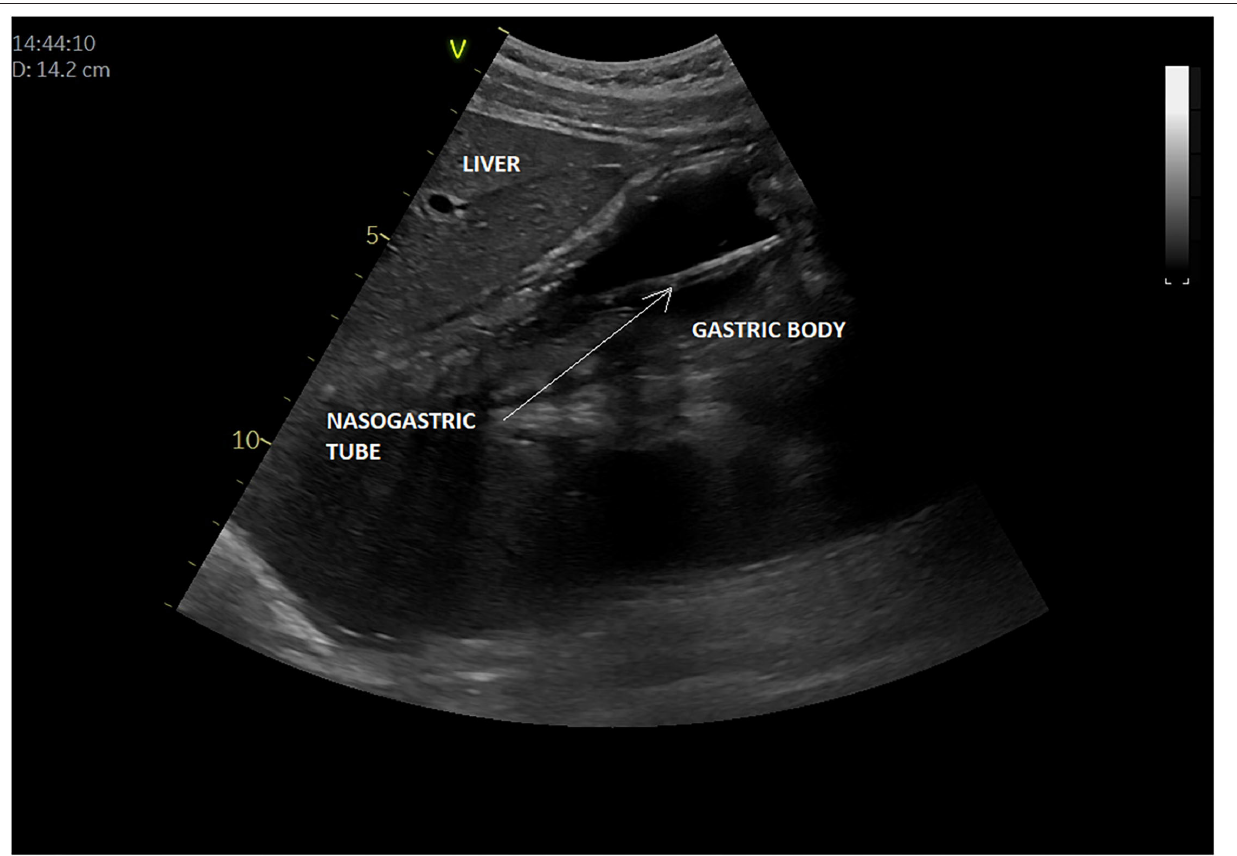
FIGURE 5 | Intragastric nasogastric tube (or orogastric tube). The gastric POCUS technique found in the literature: The NGT was visualized using the curvilinear transducer or the phased transducer (with the iScan feature to optimize the view). Probe frequency was adapted to the size of the patient. The child was positioned in a dorsal decubitus position. The transducer was positioned in the middle of the epigastric region, allowing for visualization of the tube passing through the cardia and entering the gastric area. Then the transducer was positioned in the upper right quadrant toward the duodenum, to verify whether the tube was entering the pylorus. The correct position of the NGT corresponded to a hyperechogenic line passing through the cardia with its length continuing within the gastric area but not entering the pylorus. Otherwise, the transducer was placed transversely over the xiphisternum and was fanned downward and aimed toward the left upper quadrant to visualize the gastric body through the left lobe of the liver. Then, sagittal and transverse sweeps were performed over the epigastric area. If the NGT was not identified, the transducer was placed over the left flank in the sagittal position using the spleen as a window. The study was considered positive when the NGT could be visualized in the stomach as two parallel hyperechoic